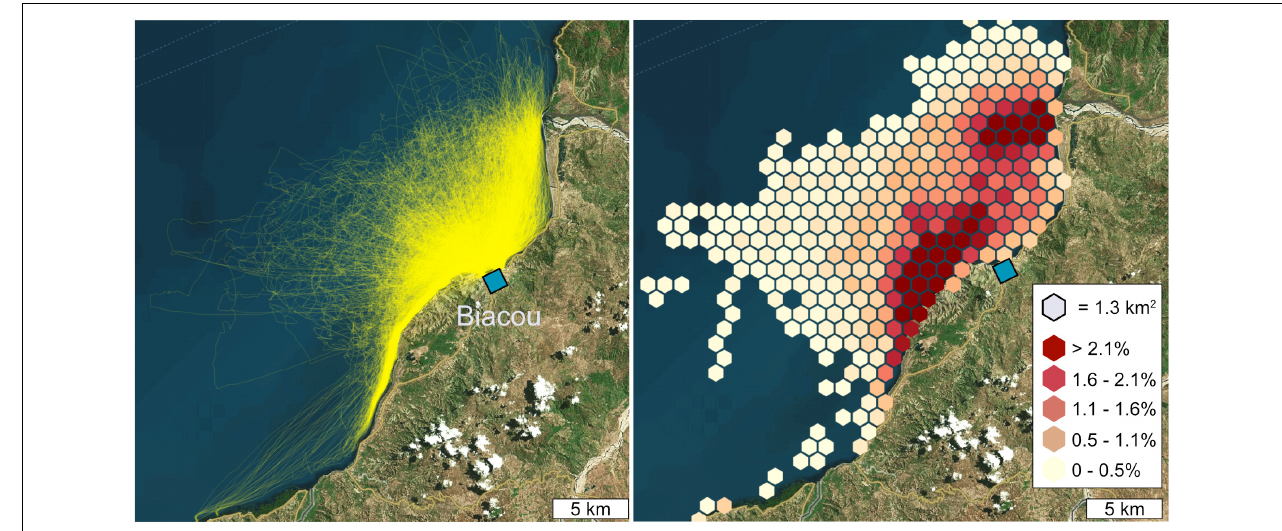
FIGURE 3 | Continuous tracking data and a fishing density heat map for 20 SSF vessels in Biacou from February 2018 to May 2019. The heat map color gradient is continuous and reflects the proportion of total fishing effort in hours for that hexagonal area. © Pelagic Data Systems. Satellite Imagery ESRI-Leaflet